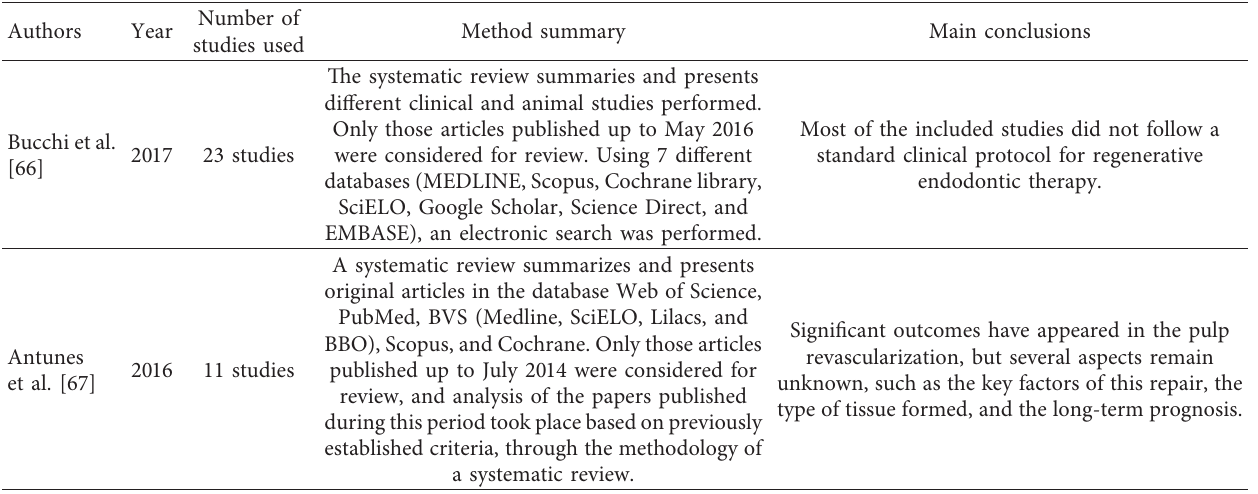
Table 4: Summary of all old systematic reviews in the scope of our systematic